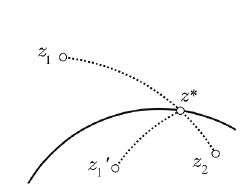
with z ∗ , from where 1